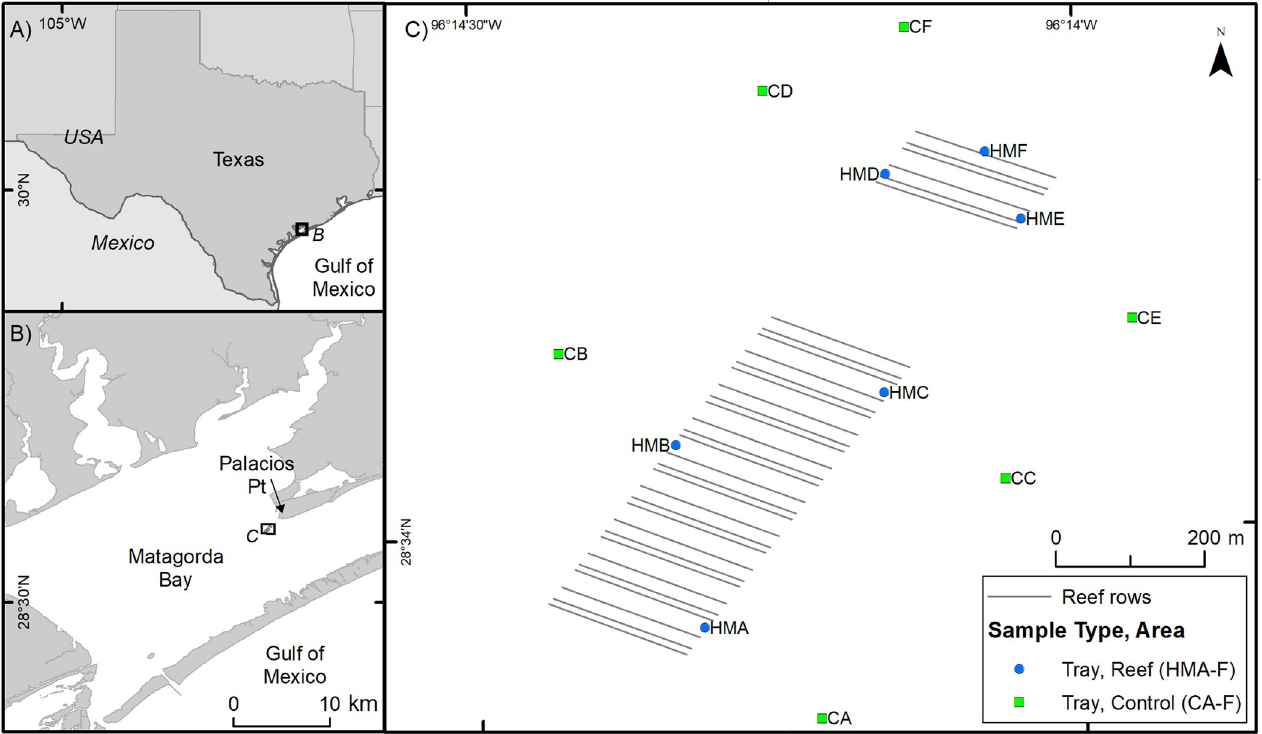
Fig 1. Study area and sampling sites at Half Moon Reef, Matagorda Bay, Texas, USA. The constructed reef was designed to maximize vertical relief and reef edge, resist wave damage, and minimize sediment accumulation. The HM and C prefixes of site names refer to Half Moon Reef (constructed reef) and Control sites,